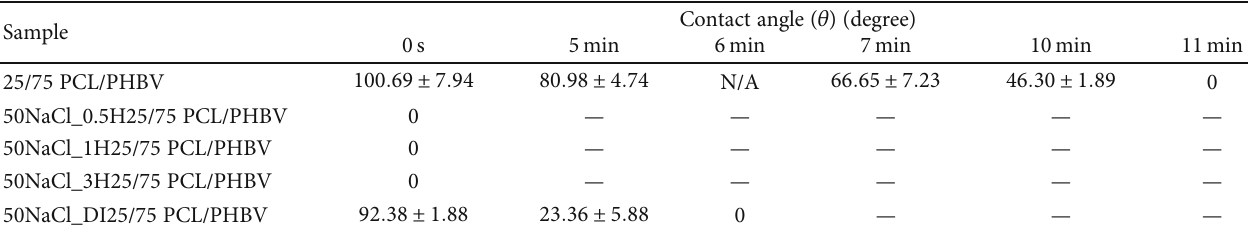
Table 5: Water contact angles as function of time of 25/75 PCL/PHBV sca ff olds without local pore and with local pores obtained from di ff erent concentrations of